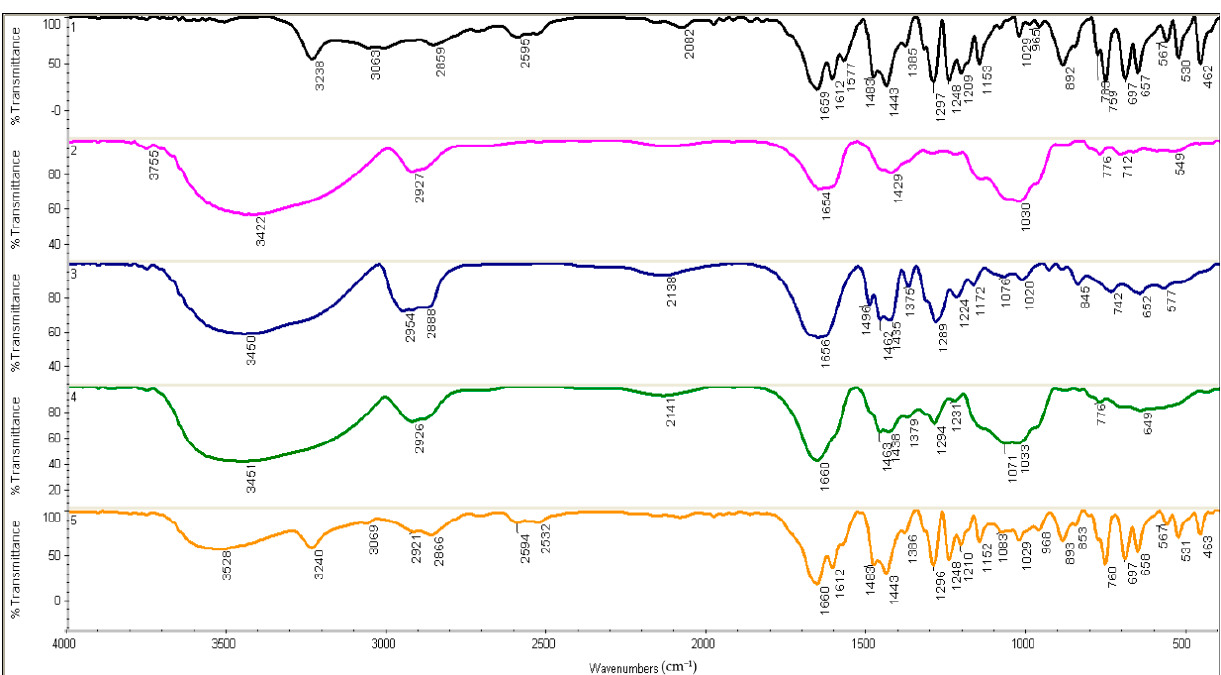
Figure 1. FTIR spectra of (1) SA, (2) GA, (3) PVP, (4) GA/PVP, and (5) GA/PVP/SA 2 mM. FT-IR, Fourier transform infrared spectroscopy; SA, salicylic acid; GA, gum arabic; PVP, polyvinylpyrrolidone. Table 1. Effect of different treatments of gum arabic (GA) and polyvinylpyrrolidone (PVP) blend- ing with salicylic acid (SA) at different concentrations as a mixture biopolymer coating treatment (GA/PVP–SA) on physical properties of peach fruit ‘Early Sweet’ during shelf life at ambient air (29 ± 1 ◦ C and air humidity 51%) during two seasons (2020 and